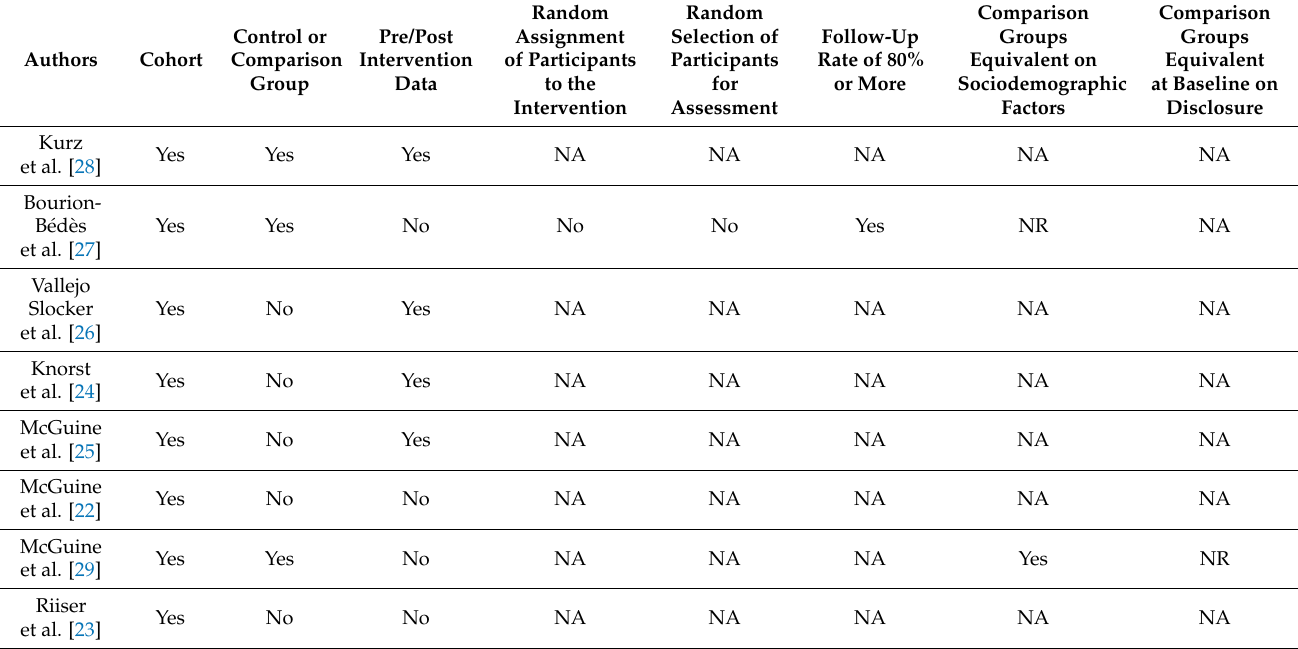
Table 1. Risk of bias in included articles assessed using the Evidence Project risk of bias tool ( n = 8).